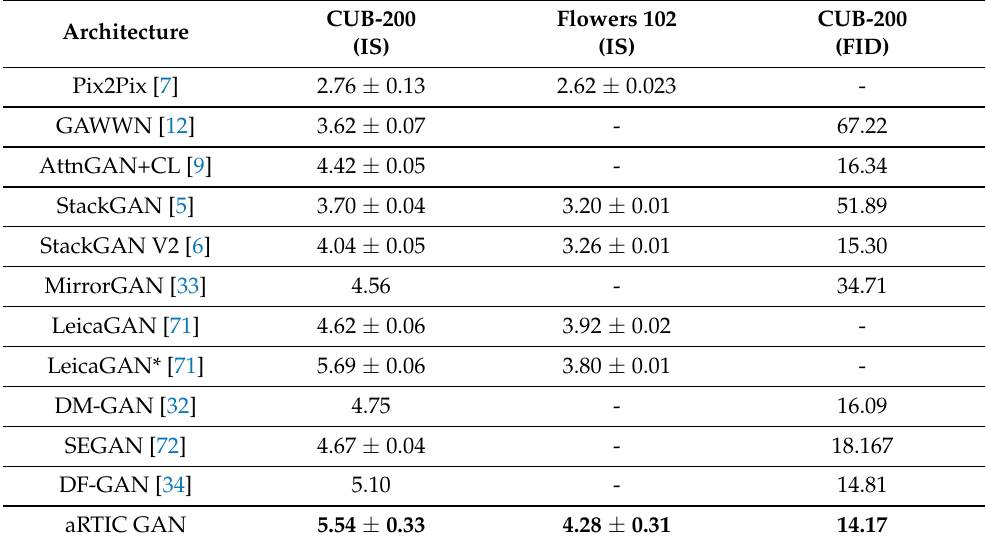
Figure 11. The use of a single sketch and multiple captions (e.g., C1 and C2) allows aRTIC GAN to generate different color patterns as opposed to I2IT methods (e.g., Pix2Pix). Table 4. Acomparison between our method and other models using IS and FID scores as metrics computed over both CUB-200 and Flowers